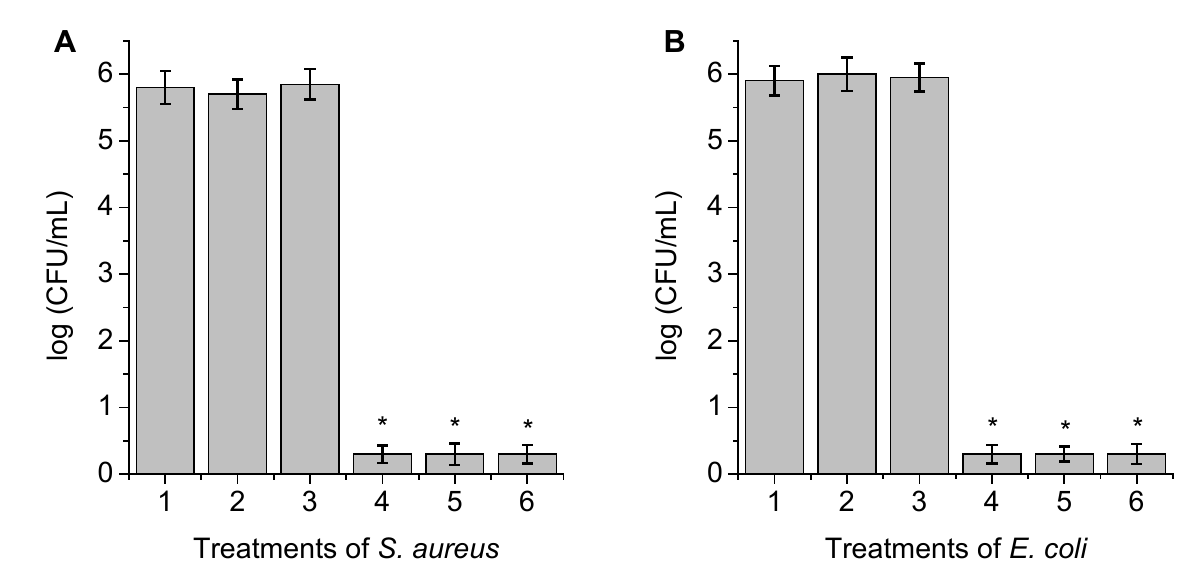
Figure 6. Survival of ( A ) S. aureus and ( B ) E. coli (~ 10 6 CFU/mL) deposited on chamber with PZnTEP attached at the surface and exposed to white light for 30 min: (1) dark control, (2) chamber without PZnTEP and 30 min irradiation, (3) chamber with PZnTEP in the dark, (4) 1st cycle chamber with PZnTEP and 30 min irradiation, (5) 2nd cycle chamber with PZnTEP and 30 min irradiation, (6) 3er cycle chamber with PZnTEP and 30 min irradiation. Inactivation was assessed in a 3D-printed